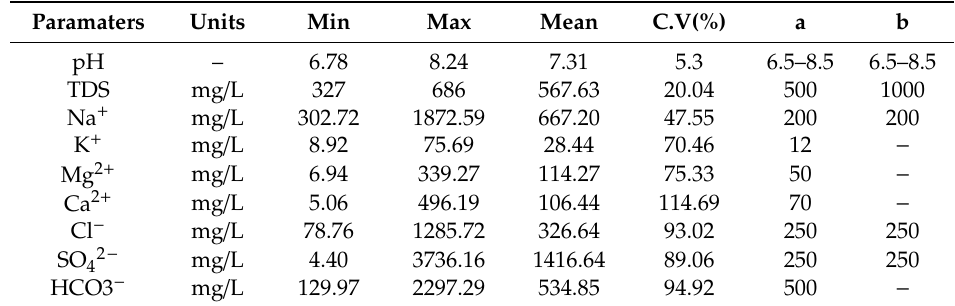
Table 2. Statistical characteristics of constant composition of the Taiyuan formation limestone water.C.V:Coe ffi cient of variation.